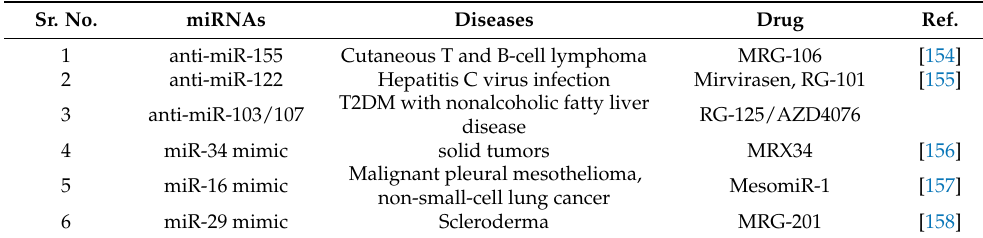
Table 2. List of miRs in clinical trial for treatment of various diseases. Sr. No. miRNAs Diseases Drug